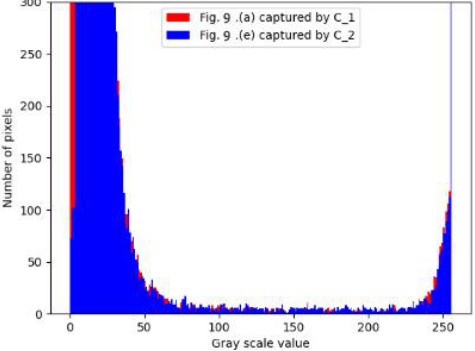
Fig. 10. Histograms of Fig.9. (a) and Fig.9.